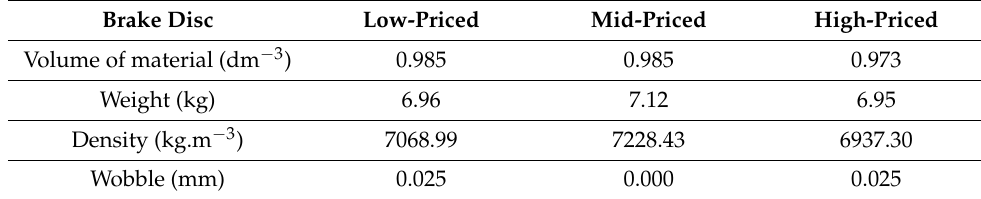
Table 4. Basic physical characteristics of brake discs.